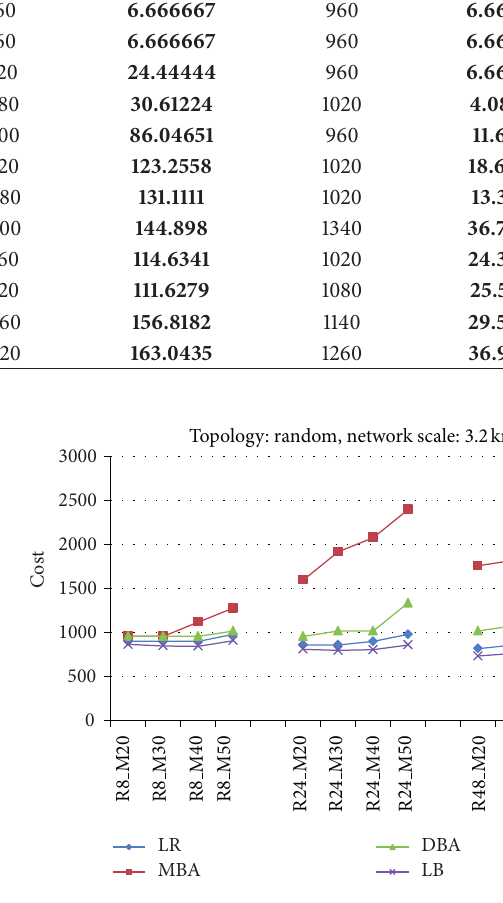
Figure 10: Deployment cost with different number of RS and MS (1BS, random,